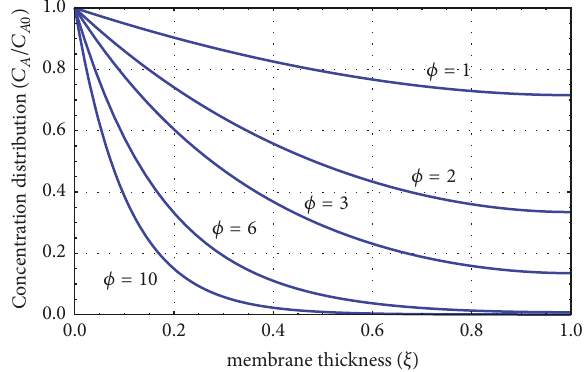
Figure 9: Simulation of concentration distribution across the catalytic layer at different values of reaction modulus as function of membrane